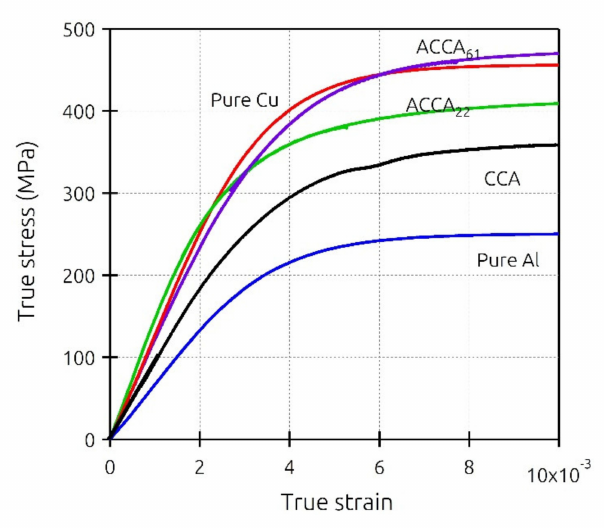
Figure 5. Illustration of the tensile curves of the different wires considered in this study: pure Al, pure Cu, copper clad aluminum (CCA) and architectured copper clad aluminum wire with 61 (ACCA 61 ) and 22 restacked wires (ACCA 22